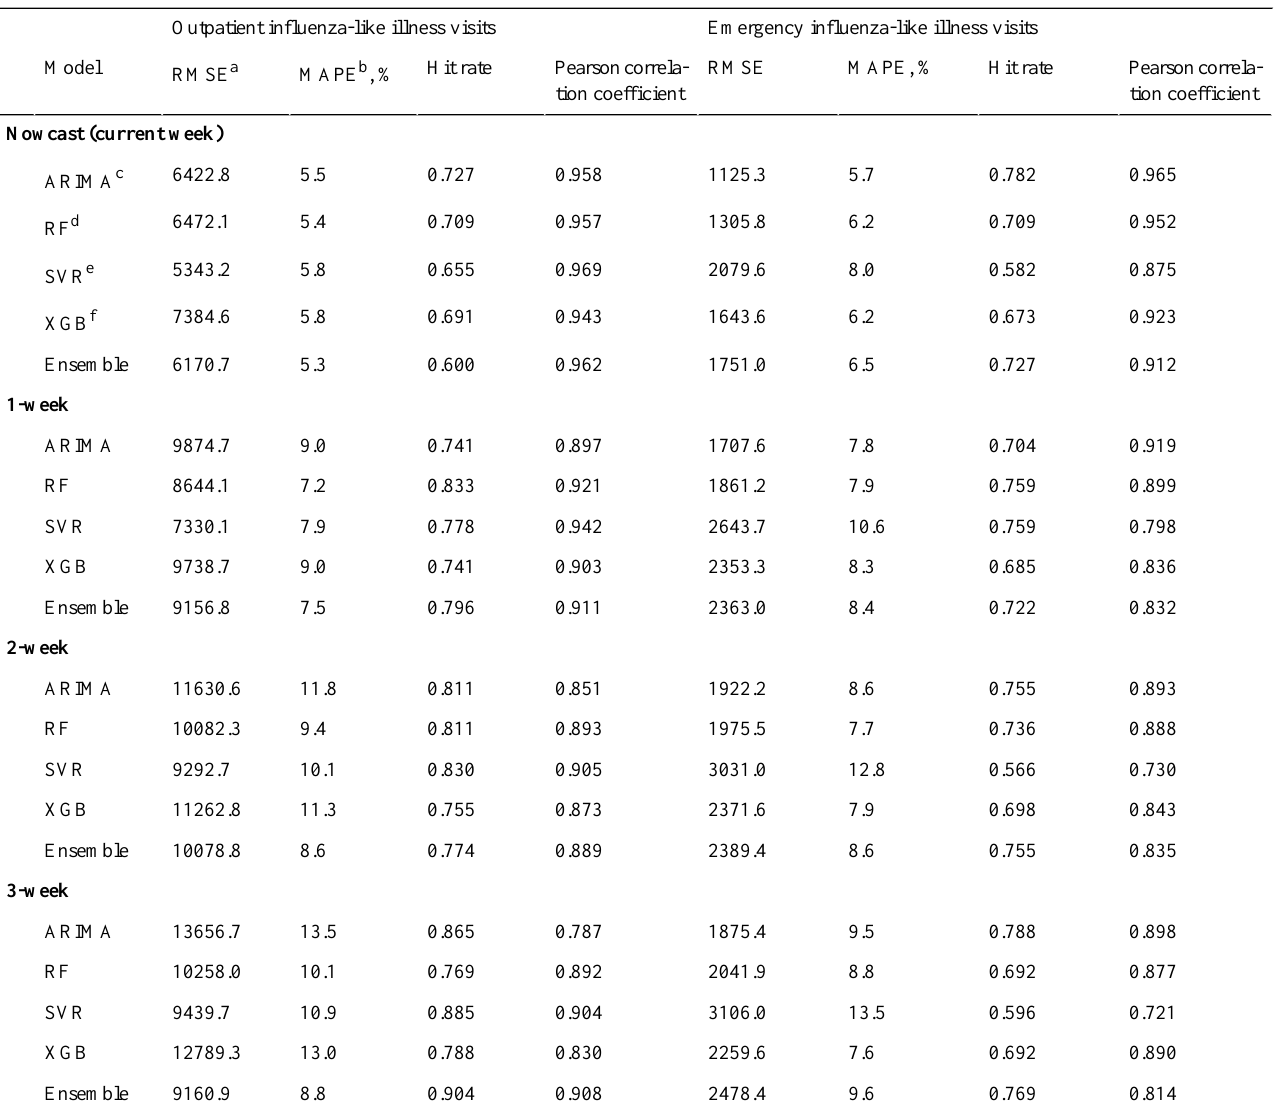
Table 2. Evaluation metrics of the 5 machine learning models for the current week forecasts (nowcast), 1-week forecasts, 2-week forecasts, and 3-week forecasts in